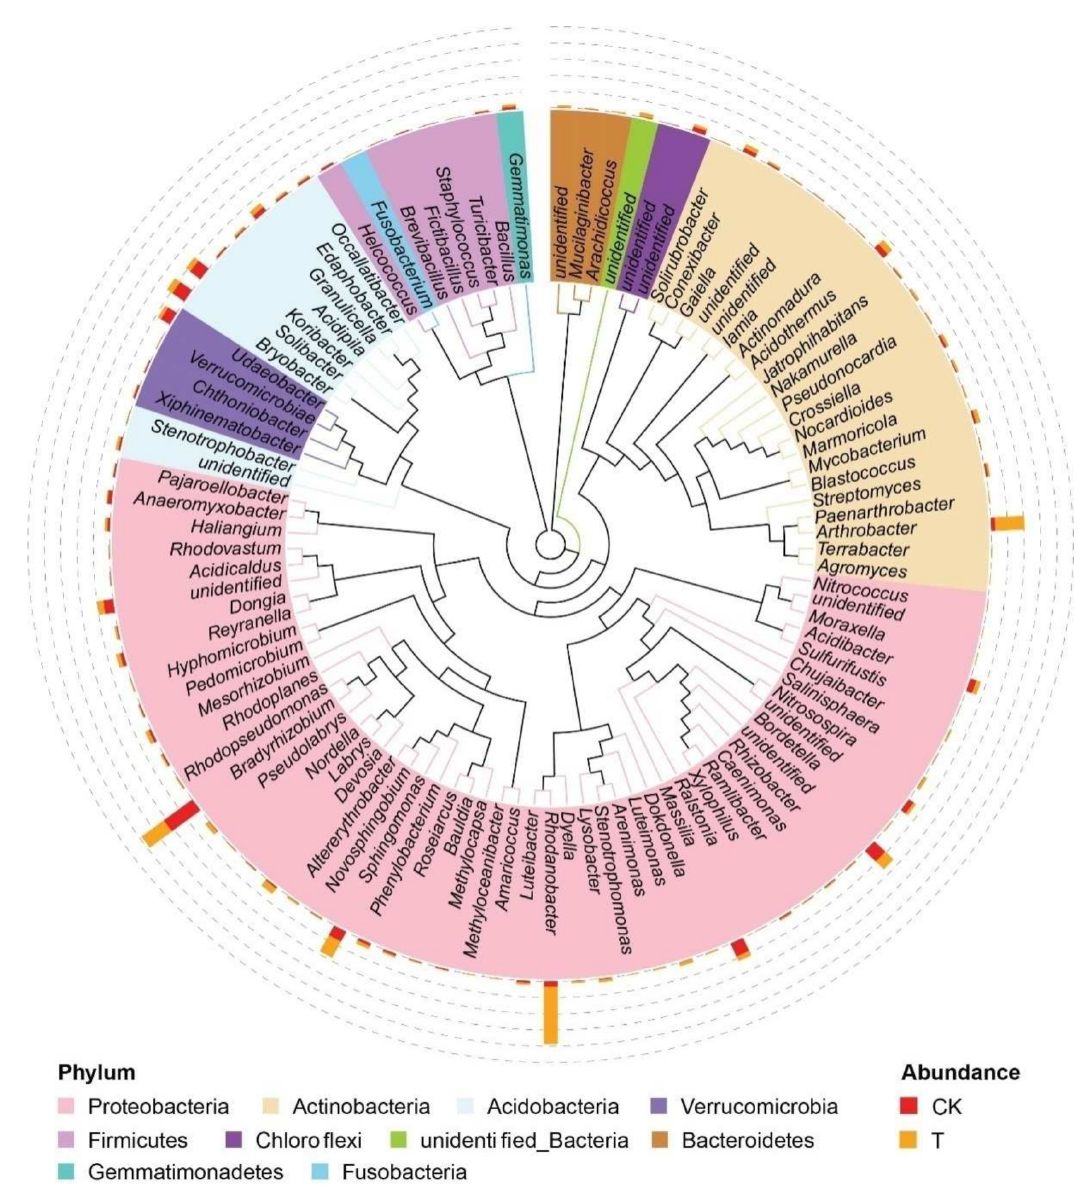
Figure 5. Phylogenetic evolutionary tree of rhizosphere bacterial microbiota at the genus level from the bioorganic fertilizer and no-fertilizer treatments. Different colors of the branches represent different phyla. The relative abundance of each genus displayed outside the circle with orange (T, bioorganic fertilizer) and red color (CK, no-fertilizer). Covering the phylum to genus level, the genera that significantly changed in abun- dance after adding the bioorganic fertilizer were identified using the Welch’s t-test.